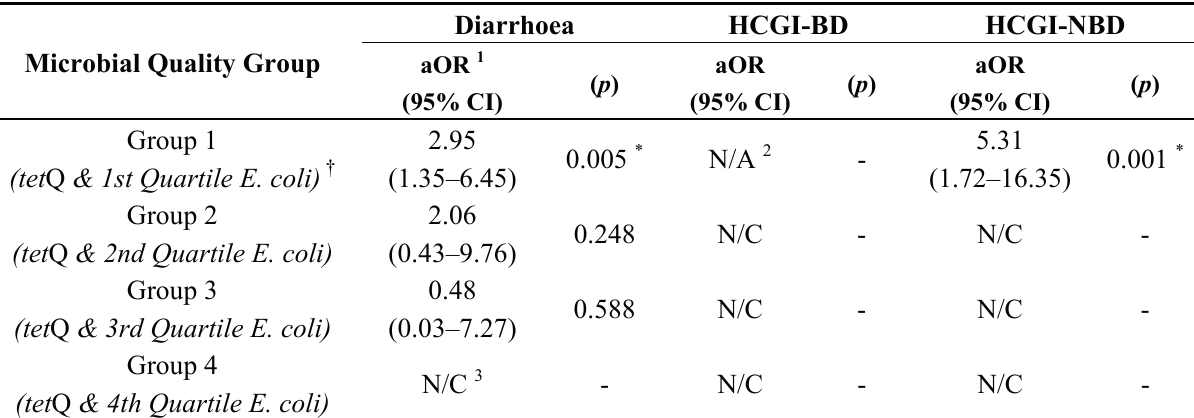
Table 7. Adjusted odds ratios for diarrhoea, HCGI-BD & HCGI-NBD associated